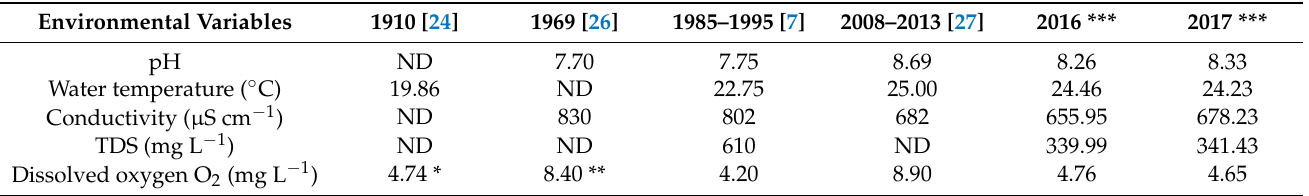
Table 3. Historical and current environmental mean data of the water column recorded by previous surveys and this study. Juday (1915) [24], Brezonik & Fox (1974) [26], Basterrechea-D í az (1997) [7], Ellenberg (2014) [27]. ND: no data